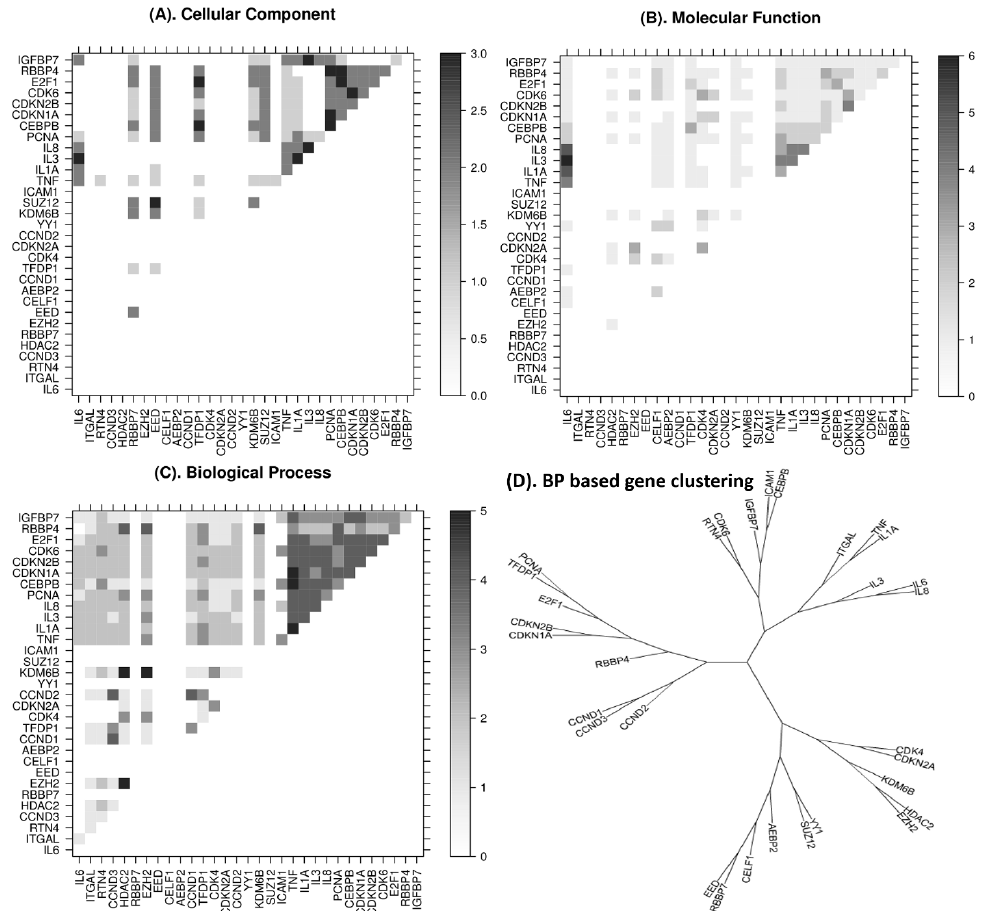
Figure 3. Gene Ontology based semantic similarity among differentially expressed genes. Pairwise comparison of these genes computed using Cytoscape/GeneMANIA plugin (version 3.3.4). Upper diagonal is the semantic similarity matrix excluding self-comparisons. Darker gray-scale represents higher gene ontological relatedness. Pairwise functional similarity graded by the ( A ) cellular component based semantic similarity measured among the genes in pathways observed from the network gene pairs IGFBP7-IL3, RBBP4-PCNA, RBBP4-CEBPB, RBBP4-CDKN1A, CDk6-CDKN1A, E2F1-TFDP1, having some of the strongest connectivity in cellular component based ontology analyses. ( B ) In molecular function (MF) based similarity analysis, ILE family genes are making the strongest pathway connections among themselves and cell-division kinases. ( C ) Compared to cellular component and molecular function analysis, we observed the strongest connectivity in biological process. Immunoglobulins/kinases are one of the strongest subgroups within these gene sets. This indicates the complex and aggressive nature of tumor cells and strong roles of miRNA regulations as well. ( D ) Genes clustered from the biological process-based similarity matrix, which highlights spatial arrangement of the DE genes in relation to the pathways